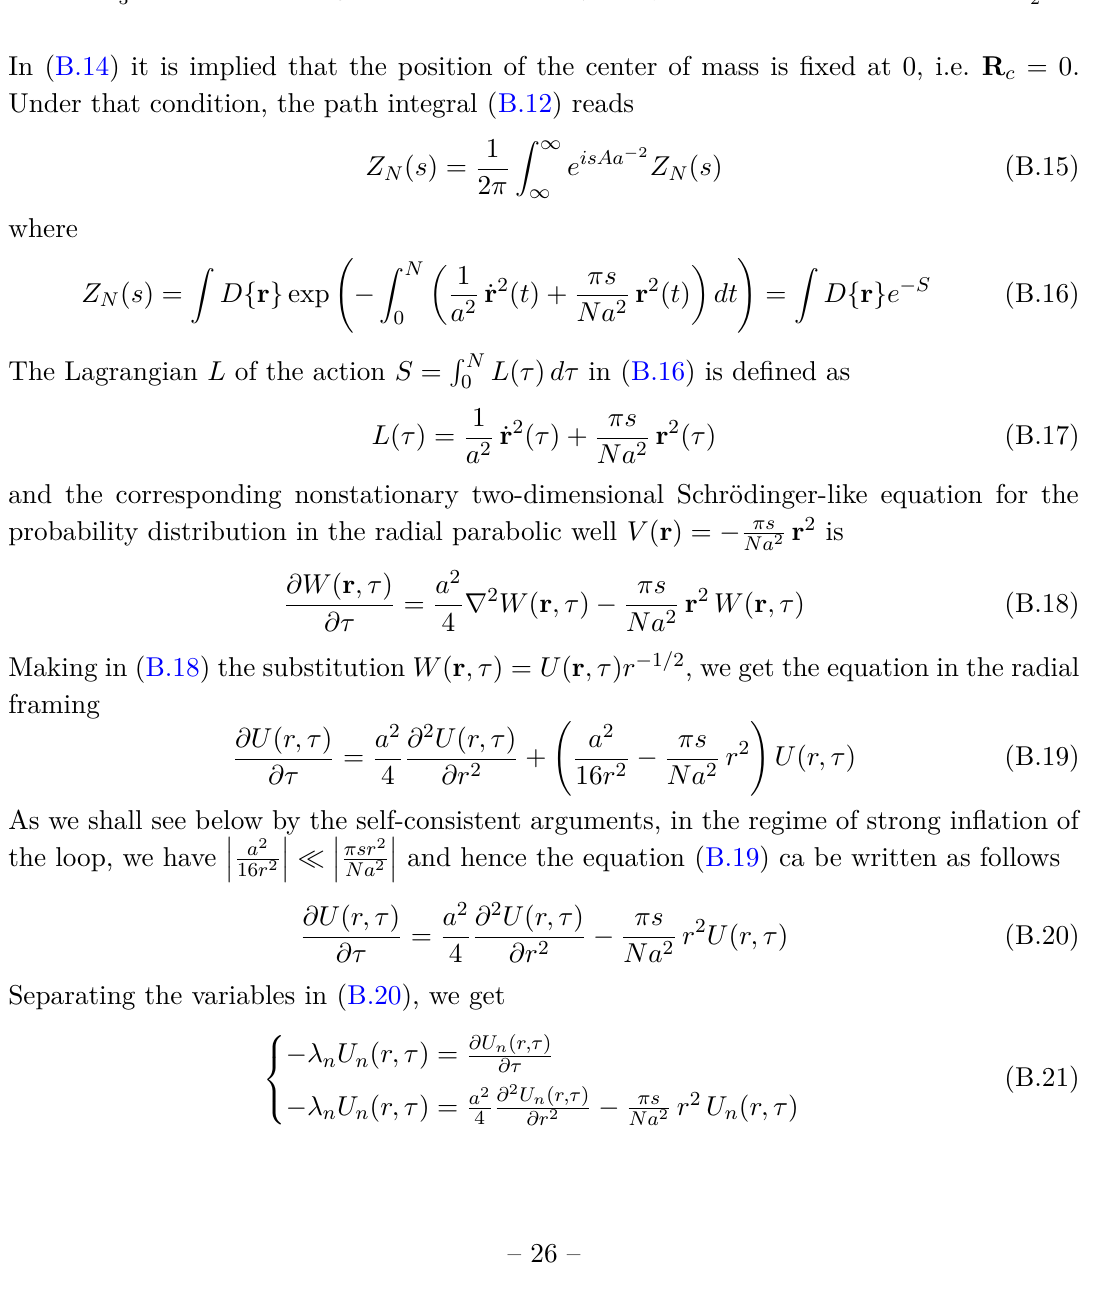
÷ 10 ) the exponent γ is close to the KPZ 2 2